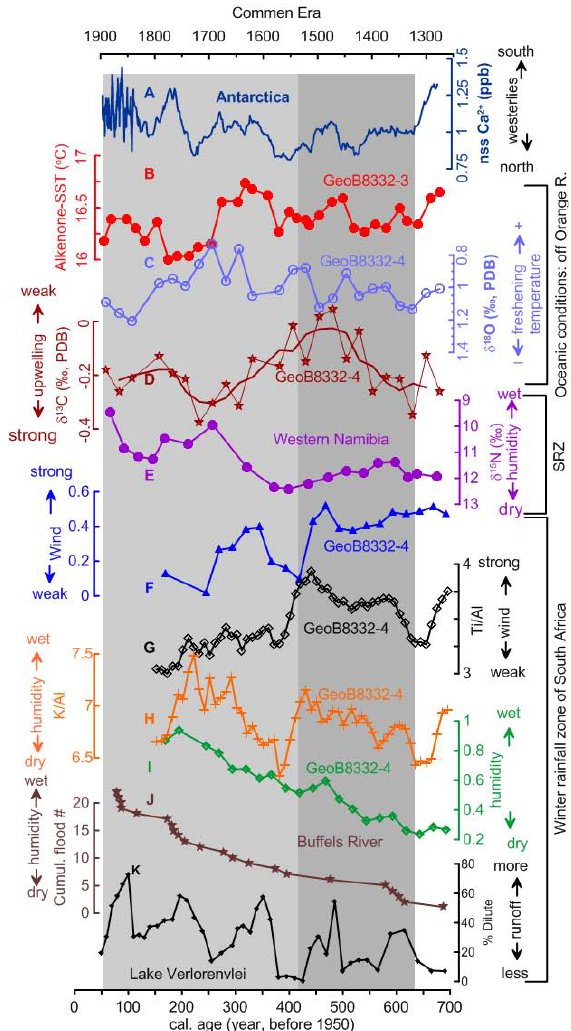
Fig. 7. Environmental conditions during the “Little Ice Age” in southwestern Africa. (A) 21-point running average of non-sea-salt Ca 2 + (nss Ca 2 + = Na − 0.038*Ca 2 + ) analyzed in a Antarctic ice core (Siple Dome) (Kreutz and Mayewski, 1999). (B) Alkenone- based SST estimates off Holgat River analyzed in GeoB8332-3 (Leduc et al., 2010). Note that the locations of GeoB8332-3 and GeoB8332-4 are identical. (C) δ 18 O and (D) δ 13 C analyzed in N. pachyderma (sinistral) in core GeoB8332-4. (E) δ 15 N analyzed in hyrax dung from the SRZ in western Namibia (Chase et al., 2009). (F) Wind strength inferred from grain size analyses and modeling in core GeoB8332-4. (G) Ti/Al and (H) K/Al analyzed in core GeoB8332-4. (I) Humidity index inferred from grain size analyses and modeling in core GeoB8332-4. (J) Cumulative flood number over the last 700 cal years BP reconstructed in Buffels River banks (Benito et al., 2011). (K) Percentage of diatom assemblages that are indicative for enhanced runoff in Lake Verlorenvlei (Stager et al., 2012). Dark gray area indicates time interval when fluvial prox- ies suggest wet conditions, high dust input, and strong winds in the WRZ. Light gray area indicates episode of wet conditions in both WRZ and